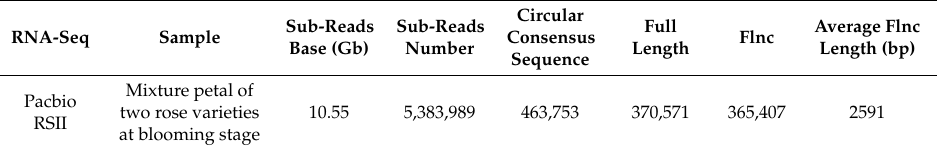
Figure 1. Petal material of Rosa ‘Margo Koster’ ( a ) and Rosa ‘White Margo Koster’ ( b ) at blooming stage used for RNA-seq ( c ) work process of bioinformatics analysis of hybrid RNA sequencing in this study. Table 1. Summary of sequencing data from PacBio